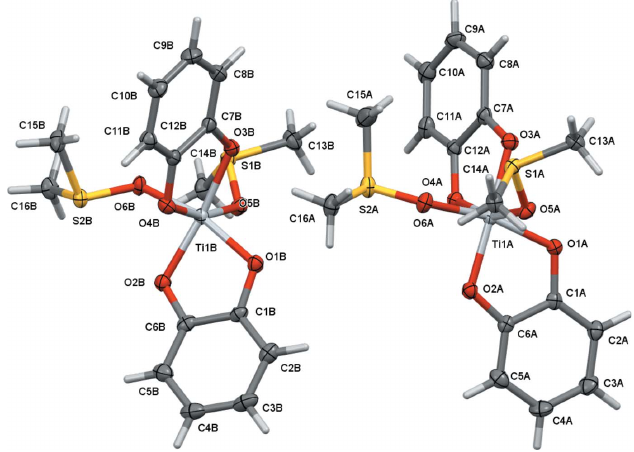
Figure 3 The two crystallographically independent molecules of 3 . View along the a axis. Molecules A and B are related by pseudo-glide operations (see discussion for